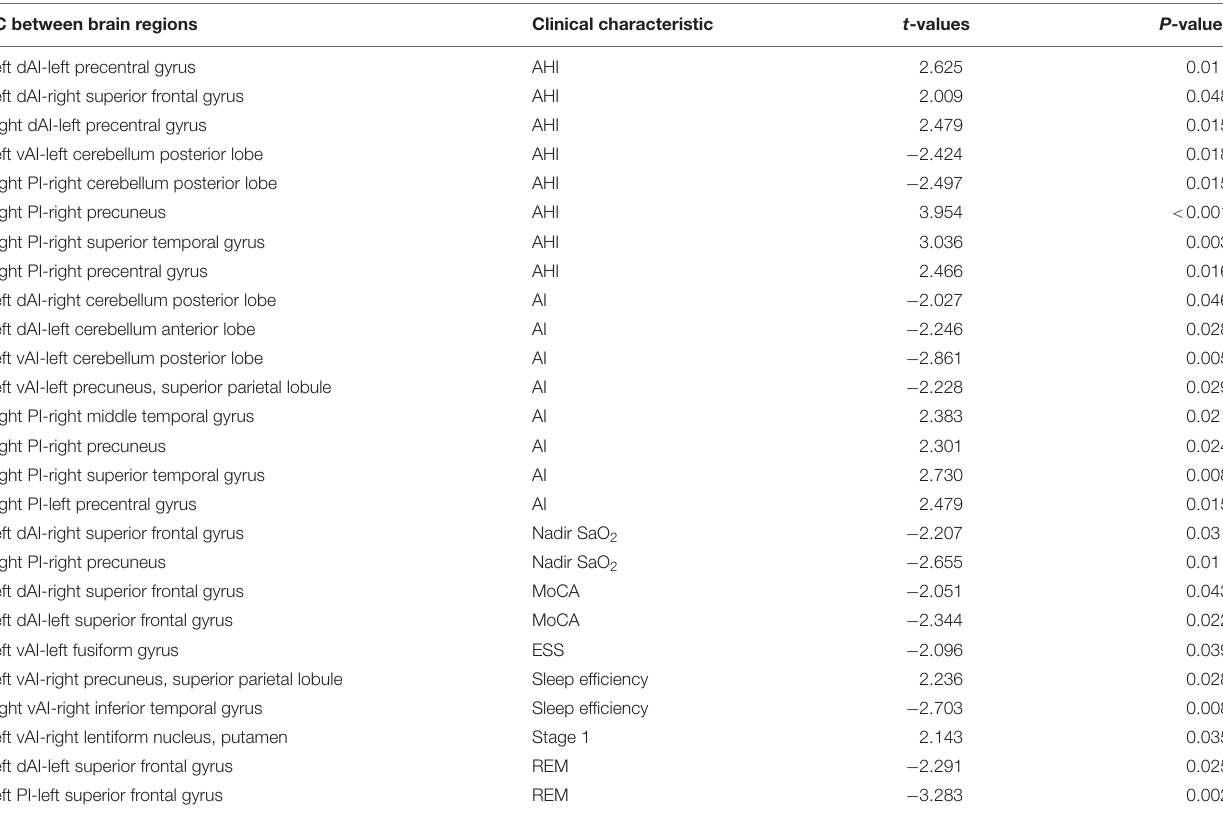
TABLE 3 | Significant associations between insular functional connectivity and clinical characteristic in OSA patients. FC between brain regions Clinical characteristic t -values P